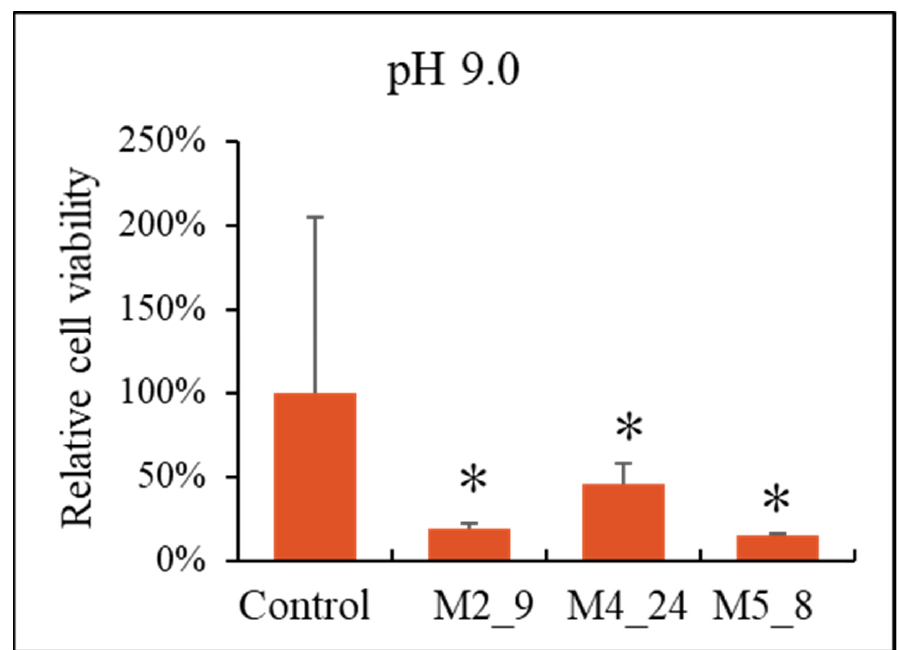
Figure 5. Effects of the bacterial culture medium alone (control, the value assumed to be 100%) and extracts from cultures of Streptomyces M4_9, M4_24, and M5_8 isolates on viability of T47D cells (assessed by the MTT test). Mean values from 3 independent experiments ± SD are demonstrated. Asterisks (*) indicate statistically significant differences ( p < 0.05) relative to the control.